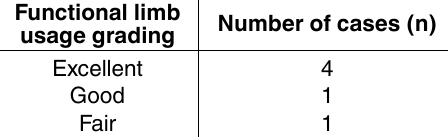
table 6. Functional limb usage (Fox et al., 1995) in dogs treated with ESIN by using TENs